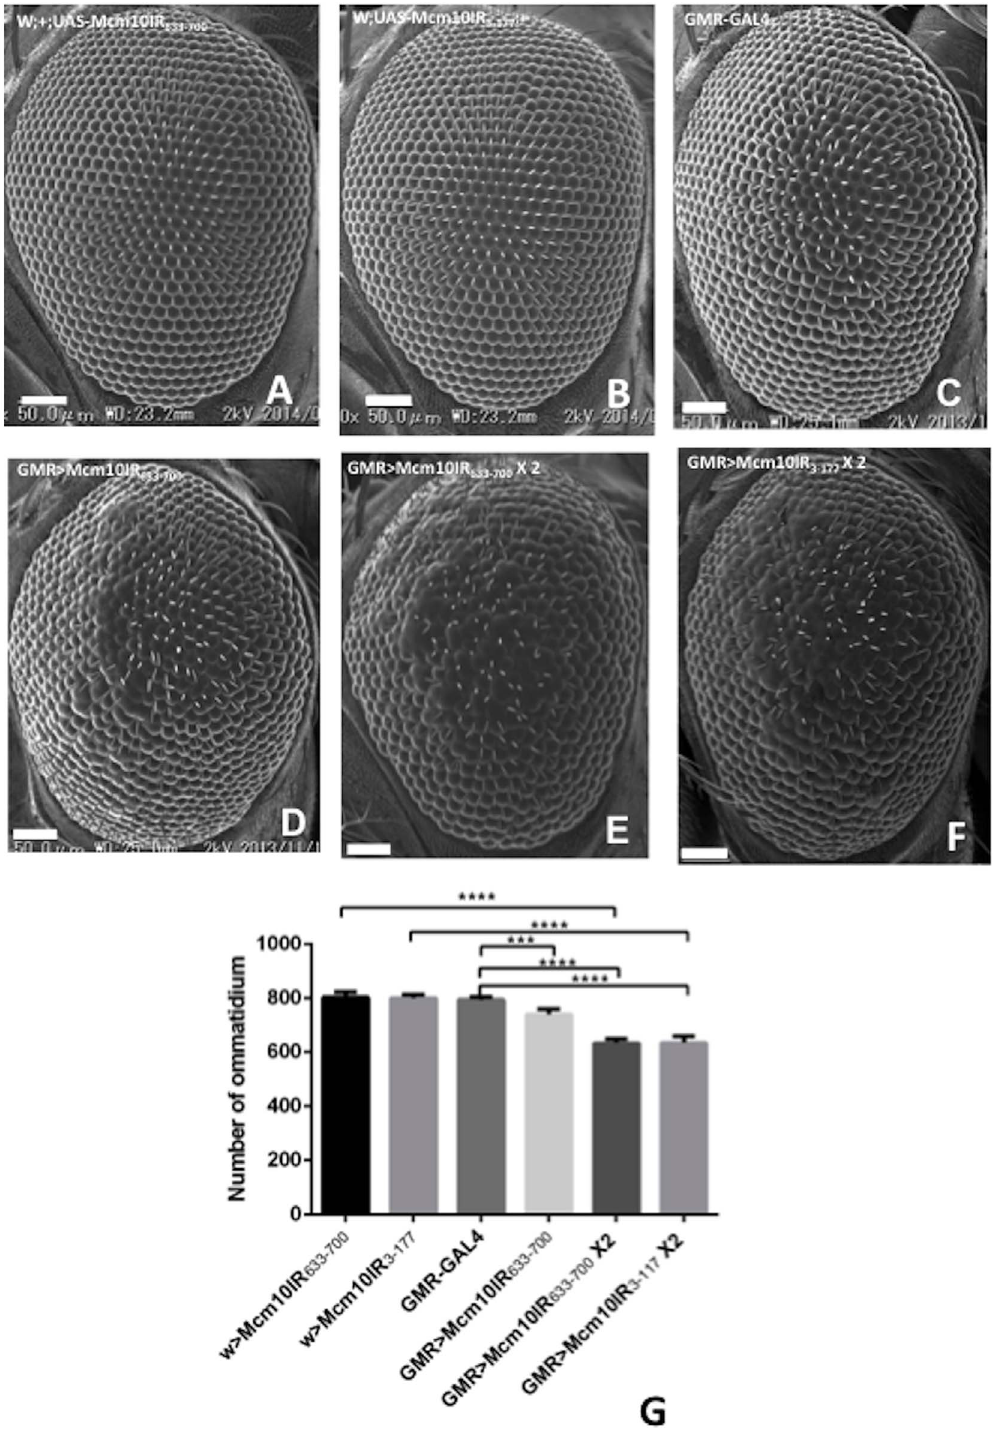
Figure 2. Knockdown of dMcm10 in eye imaginal discs causes a small and rough eye phenotype. Scanning electron micrographs of adult compound eyes. Posterior is to the right and dorsal is to the top. The bar indicates 50 m m. (A) w ; + ; UAS- Mcm10IR 633-700 ; (B) w ; UAS- Mcm10IR 3-117 ; + ; (C) GMR -GAL4/ + ; + ; + ; (D) GMR -GAL4/ + ; + ; UAS- dMcm10IR 633-700 / + ; (E) GMR -GAL4/ + ; + ; UAS- Mcm10IR 633-700 /UAS- MCM10IR 633-700 ; (F) GMR -GAL4/ + ;UAS- Mcm10IR 3-117 /UAS- Mcm10IR 3-117 ; + ; (G) Quantification of the number of ommatidium in adult eye flies. Mean intensities with standard deviation from six adult eyes are shown. ***p , 0.001, ****p , 0.0001. The flies were reared at 28 u C.